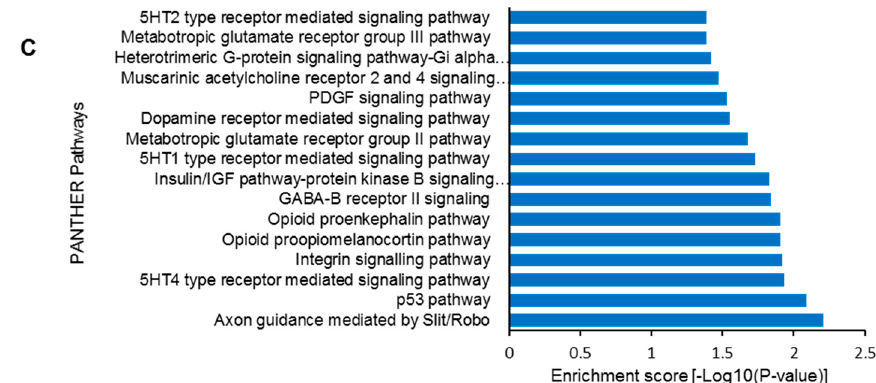
Figure 7. Prediction of ci-Ins2 –miRNA–mRNA regulatory axis. ( A ) miRNAs predicted by miRDB to associate with ci-Ins2 (486 nt). ( B ) The top 10 GO terms with the highest number of enriched genes for biological processes, cellular components, and molecular function for the mRNA targets of miRNAs associated with ci-Ins2 (486 nt). ( C ) PANTHER pathways enriched for the mRNA targets of miRNAs associated with ci-Ins2 (486